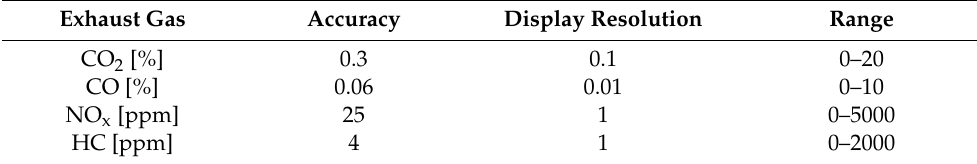
Table 8. Accuracy, resolution and range of the measurements of the exhaust gas analyzer (EMS 5003).